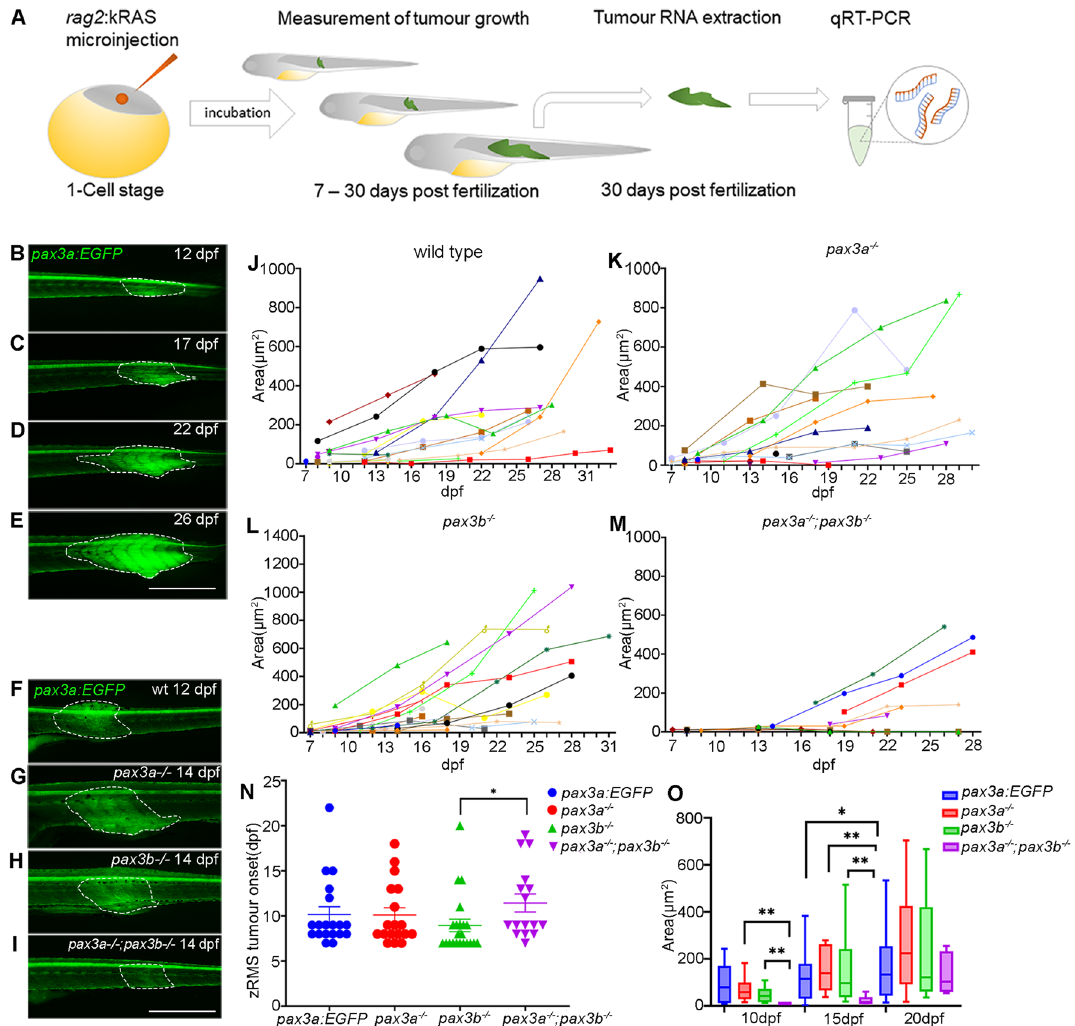
Figure 3. Functional analysis of zRMS progression in wild type and pax3 mutant zebrafish: (A) schematic illustration of generating zRMS, showing microinjection of rag2:kRASG12D into one cell stage zebrafish embryo, zRMS detection and monitoring of tumour growth from 7 to 30 dpf, tumour tissue excision and total RNA extraction at 30 dpf for gene expression analysis using qRT-PCR. (B–E) zRMS identified in pax3a:EGFP zebrafish transgenic line at 12 dpf, 17 dpf, 22 dpf, and 27 dpf. High intensity of GFP expression is observed at the tail area of the zebrafish larvae. Representative image of zRMS tumour progression (F) wild type at 12 dpf , (G) pax3a −/− at 14 dpf , (H) pax3b −/− at 14 dpf and (I) pax3a −/− ;pax3b −/− at 14 dpf. Tumour area (μm 2 ) of individual zRMS (J) wild type fish (n = 24), (K) pax3a −/− (n = 18), (L) pax3b −/− (n = 22), (M) pax3a −/− ;pax3b −/− (n = 12). (N) zRMS tumour onset is indicated in days post fertilization in wild type fish (n = 20), pax3a −/− (n = 18) , pax3b −/− (n = 22) and pax3a −/− ;pax3b −/− (n = 16) zebrafish lines. (O) Tumour area (μm 2 ) in zebrafish larvae that were injected with rag2-KRASG12D in wild type (n = 12), pax3a −/− (n = 10) , pax3b −/− (n = 16) and pax3a −/− ;pax3b −/− (n = 6) zebrafish lines at 10 dpf, 15 dpf and 20 dpf. All experiments were conducted in pax3a:EGFP background. Tumour areas are indicated with dashed lines. Error bars represent mean ± SEM and significance was calculated using Student t-test and Mann Whitney U test where p < 0.05 was considered significant, *p < 0.05, **p < 0.01, ***p < 0.001. Scale bar: 1